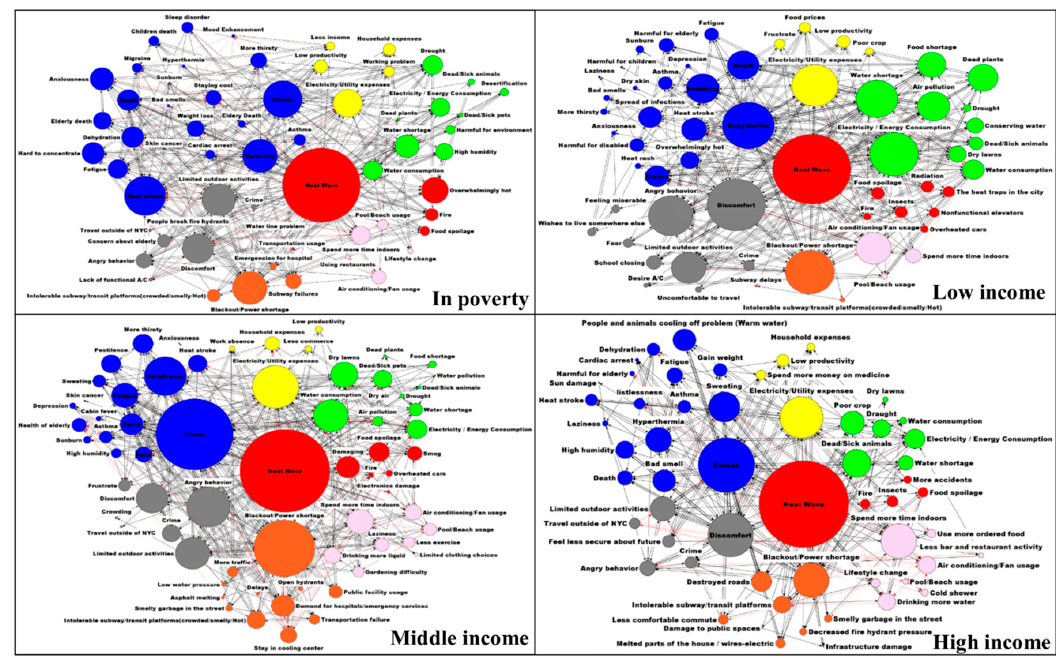
Figure 7. Visualization of the cognitive map of each income group. Legend: The size of the nodes depict centrality. The colors refer to sectors, such as health, economic aspects, social aspects, energy and natural resources, infrastructure, hazard and damages, life style.